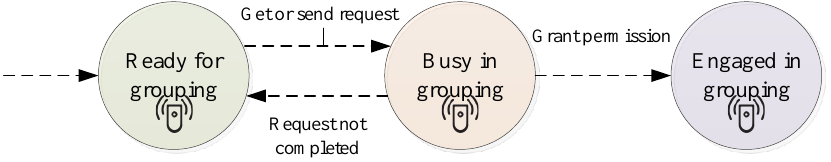
Figure 3. The three states of a sensor in smart environments.